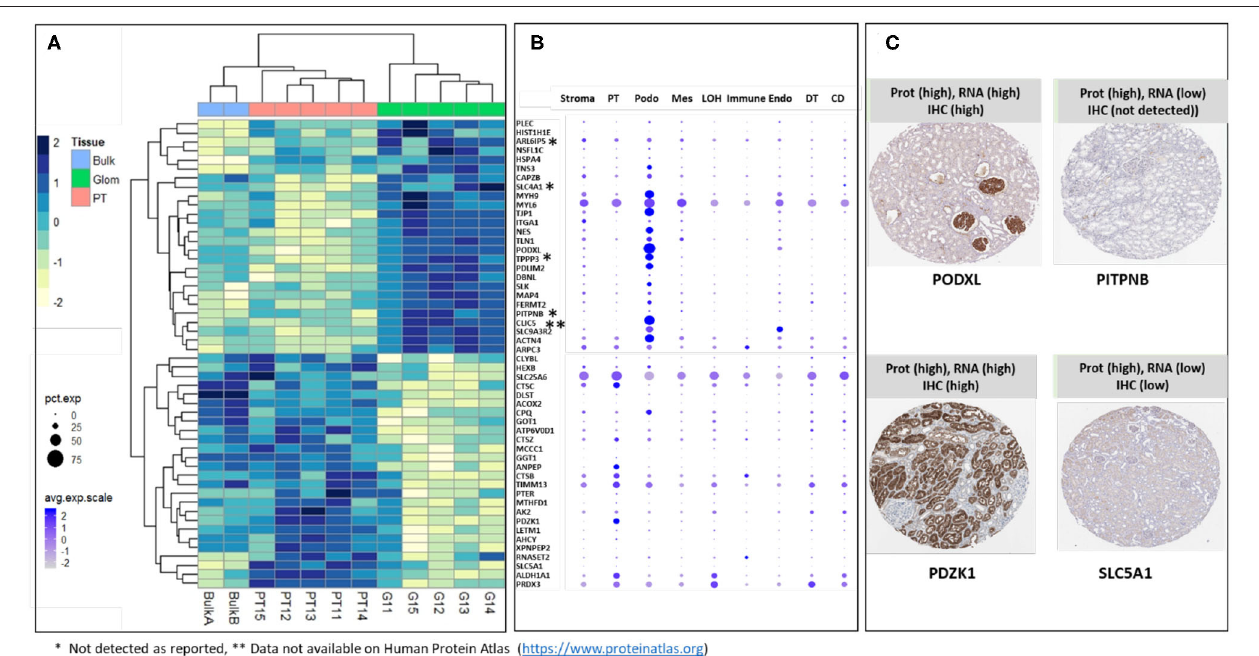
FIGURE 4 | (A) Heatmap showing differential distribution of protein abundances in 5 normal kidneys (batch 2), of 26 proteins (out of 372) most significantly enriched in G (vs T) and 26 proteins (out of 411) most significantly enriched in T (vs G), with corresponding values in 2 Bulk samples shown for comparison. Protein abundances are measured as log 2 transformed relative intensities. Unsupervised clustering of significant proteins highlights sets of proteins related by Euclidean distance similarity measure within the larger differentiated enriched sets. It is noted that Bulk samples cluster together with PT samples; this is expected since proximal tubules are abundantly dispersed within the kidney. (B) Correlation of gene expression plot of scRNA-seq data from human kidney. Genes encoding Glom-specific and PT-specific proteins presented on the heatmap were selected. Increasing dot size corresponds to a larger percentage of cells in the cell population expressing the gene, while a darker color corresponds to a higher expression of the gene. PT, proximal tubular; Podo, podocytes; Mes, mesangial cells; LOH, Loop of Henle, Immune cells; Endo, endothelial cells; DT, distal tubules; CD, collecting duct. *Sign next to the gene symbol indicates that the protein was not detected on glomeruli as reported by Human Protein Atlas (https://www.proteinatlas.org), **Data not available on Human Protein Atlas (https://www.proteinatlas.org). (C) Representative proteins that demonstrate how nscProteomics not only identifies positive markers such as PODXL and PDZK1 but also identifies protein markers such as that are otherwise missed by transcriptomics or